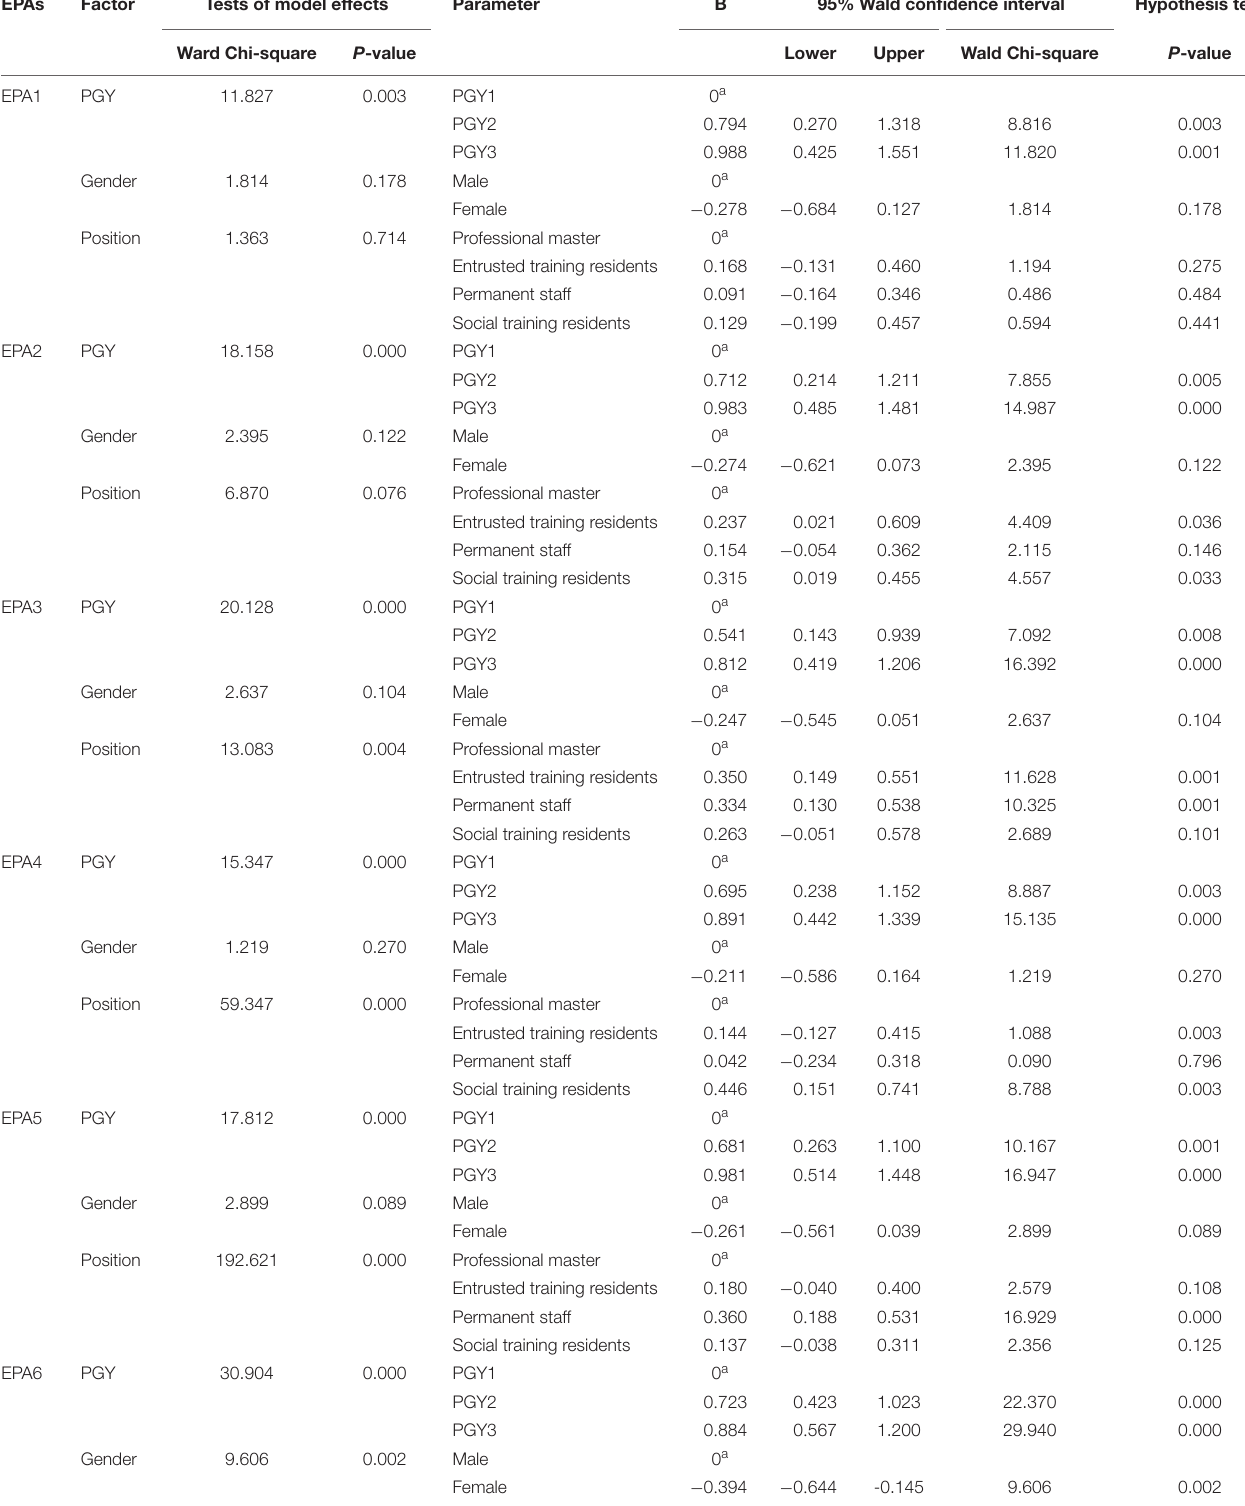
TABLE 6 | Generalized estimated equation analysis of director-assessment